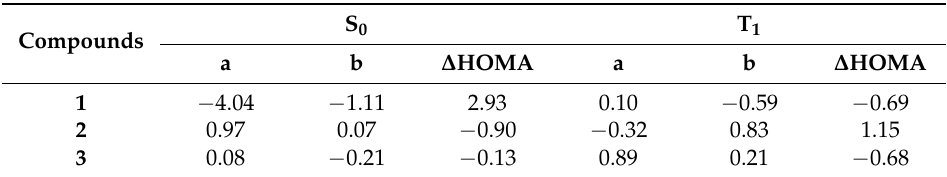
Table 1. Harmonic oscillator model of aromaticity (HOMA) values at the (U)B3LYP/6-311G(d,p) level of compounds 1 , 2 , and 3 .